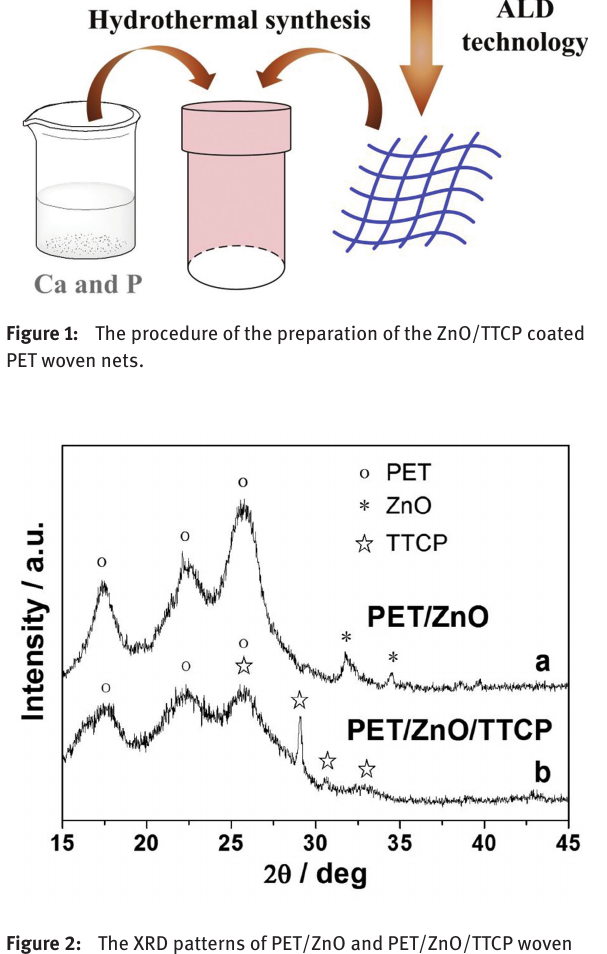
Figure 2: The XRD patterns of PET/ZnO and PET/ZnO/TTCP woven